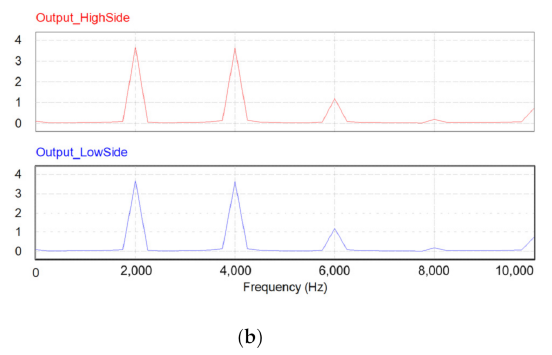
Figure 12. Frequency and FFT characteristics of Zone 3: ( a ) frequency characteristics of Zone 3